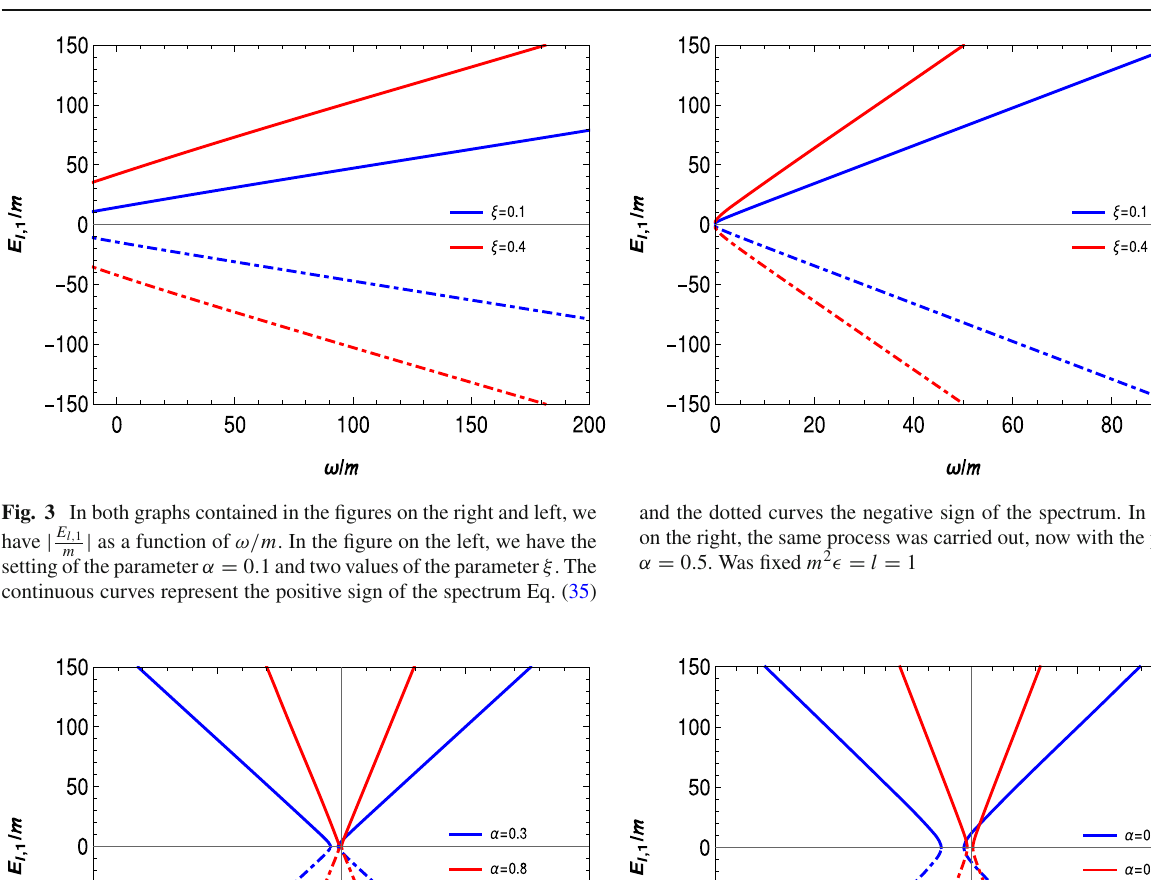
and the dotted curves the negative sign of the spectrum. In the figure on the right, the same process was carried out, now with the parameter ξ = 0 . 4. Was fixed m 2 (cid:4) = l =